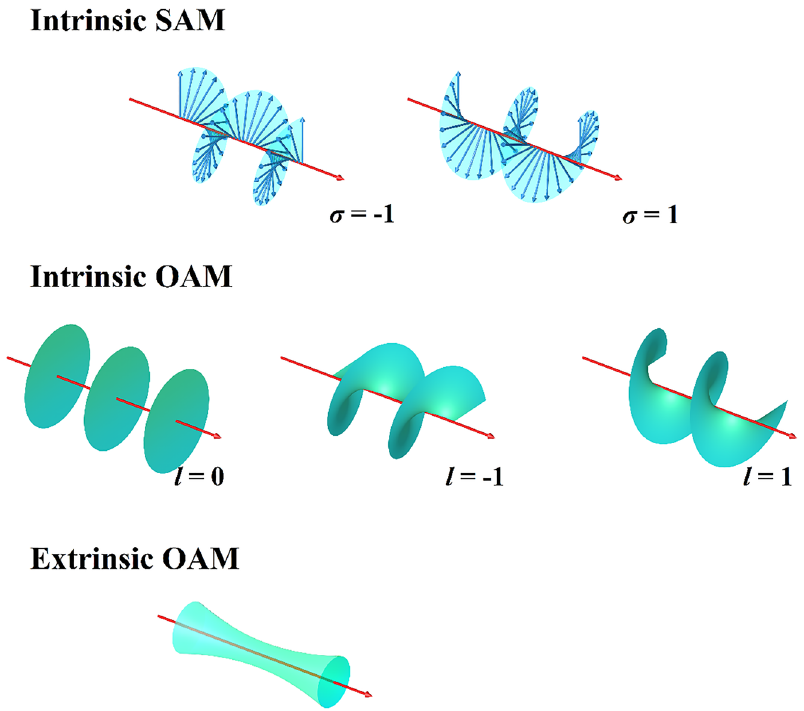
Figure 1: Diagrammatic sketch of SAM and OAM